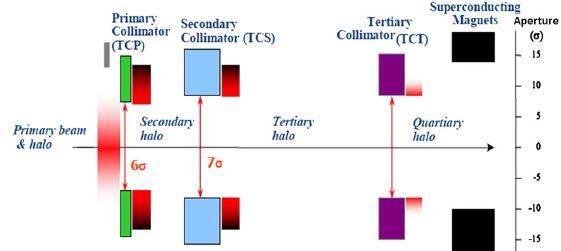
FIG. 1. Qualitative schematic diagram of the LHC multistage collimation system where the primary collimator jaws are positioned closest to the beam while the jaws of the secondary and tertiary collimators are retracted further away from the